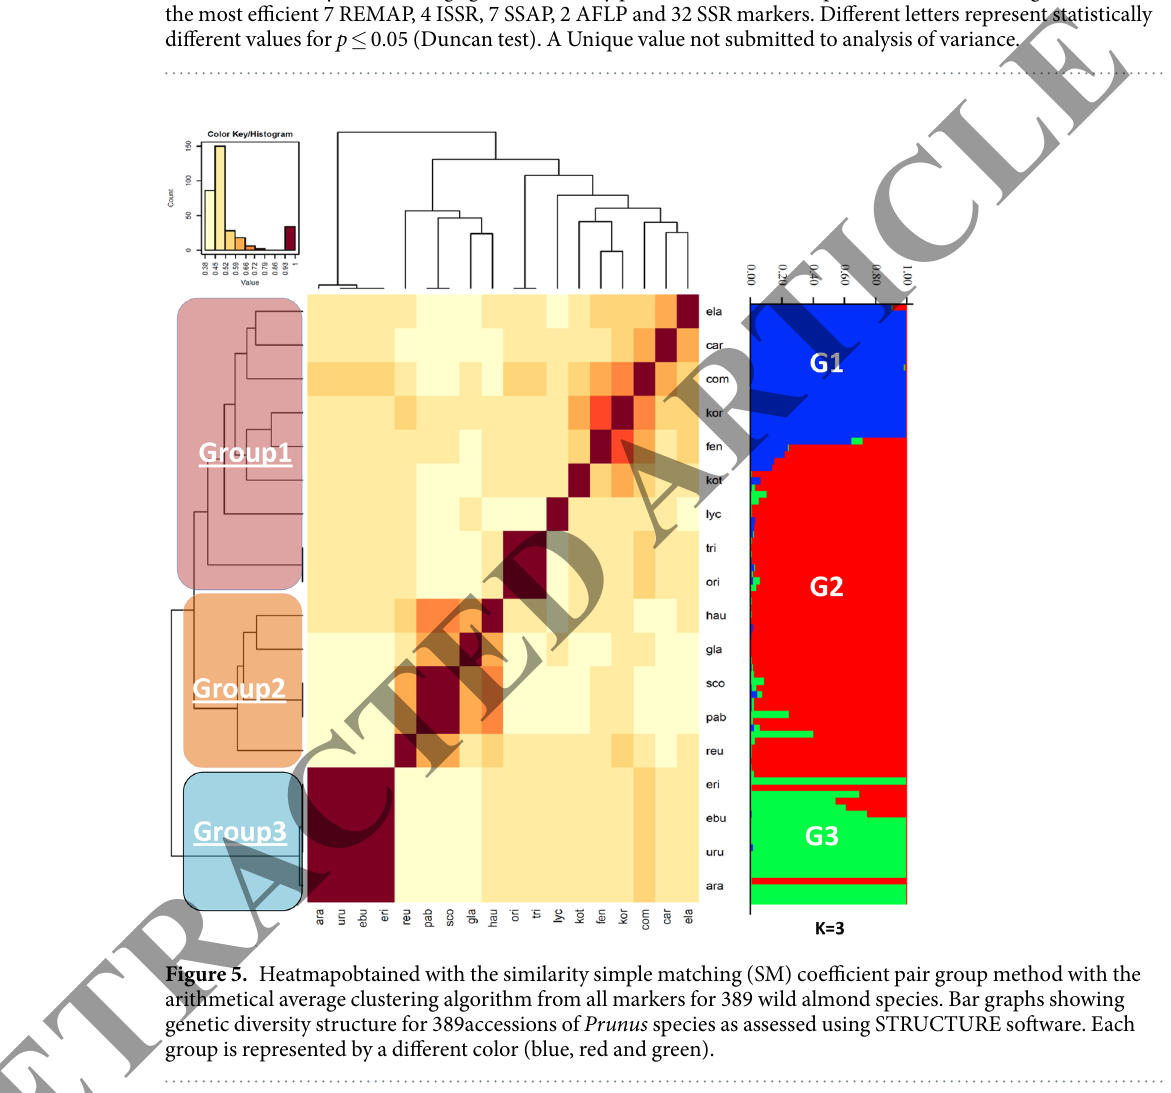
Figure 5. Heatmapobtained with the similarity simple matching (SM) coefficient pair group method with the arithmetical average clustering algorithm from all markers for 389 wild almond species. Bar graphs showing genetic diversity structure for 389accessions of Prunus species as assessed using STRUCTURE software. Each group is represented by a different color (blue, red and